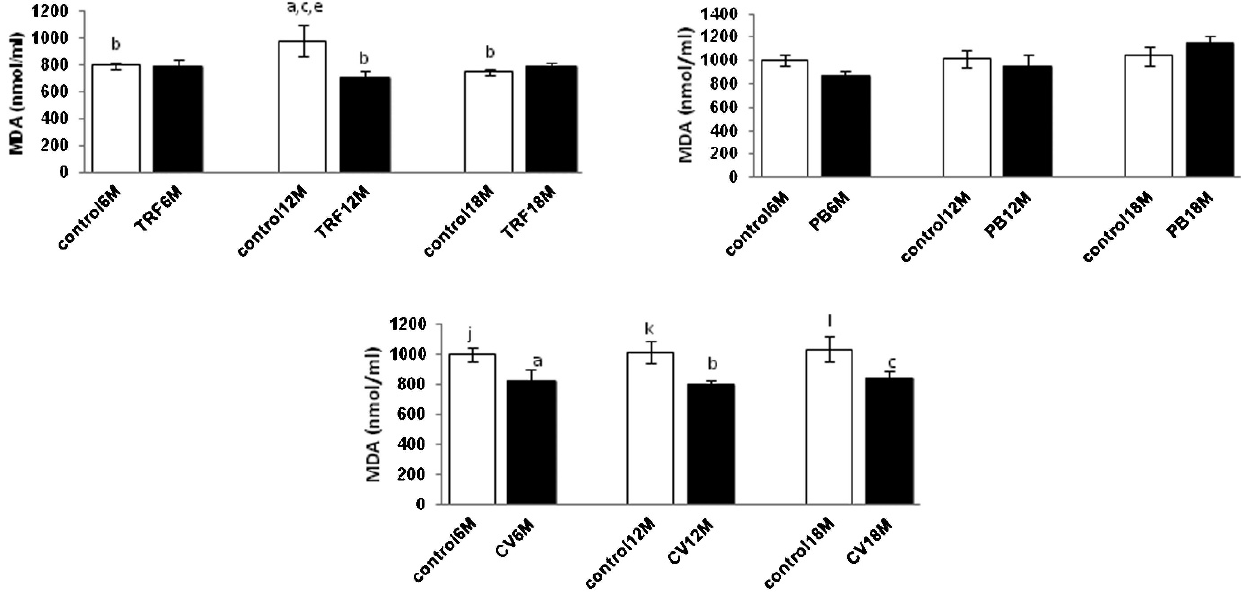
Figure 4 - Effect of PB, TRF, and CV on the plasma malondialdehyde (MDA) level in mice with different ages. Values are the mean ¡ S.E.M. for 8 mice. a-c: significantly different ( p , 0.05) from the control at 6 M, 12 M, and 18 M, respectively. d-f: significantly different ( p , 0.05) from TRF at 6 M, 12 M, and 18 M, respectively. g-i: significantly different ( p , 0.05) from PB at 6 M, 12 M, and 18 M, respectively. j-l: significantly different (P , 0.05) from CV at 6 M, 12 M, and 18 M,